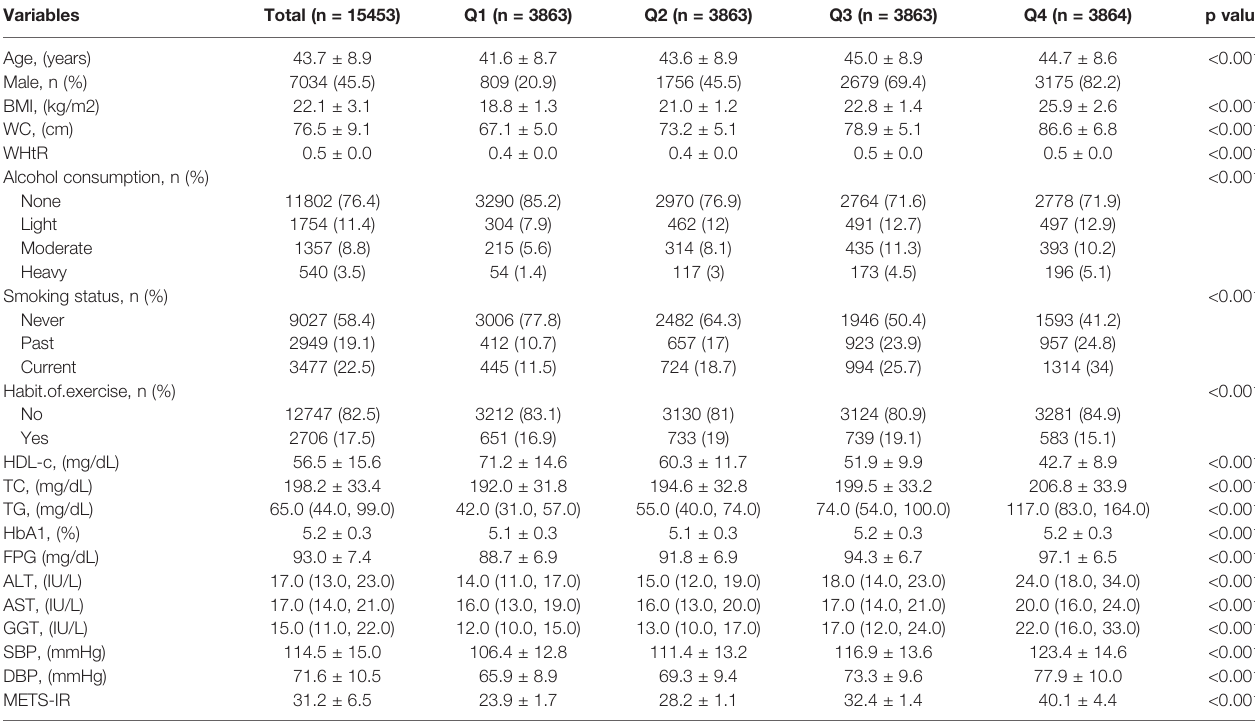
TABLE 1 | Clinical characteristics of the study population according to METS-IR.